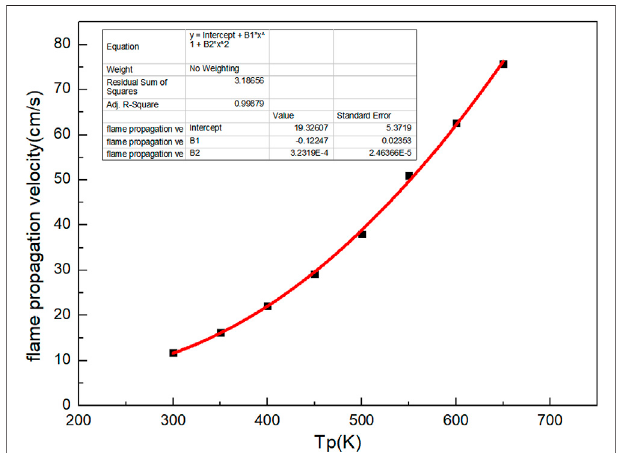
FIGURE 4 | Curve of NO mole fraction with preheating temperatures.